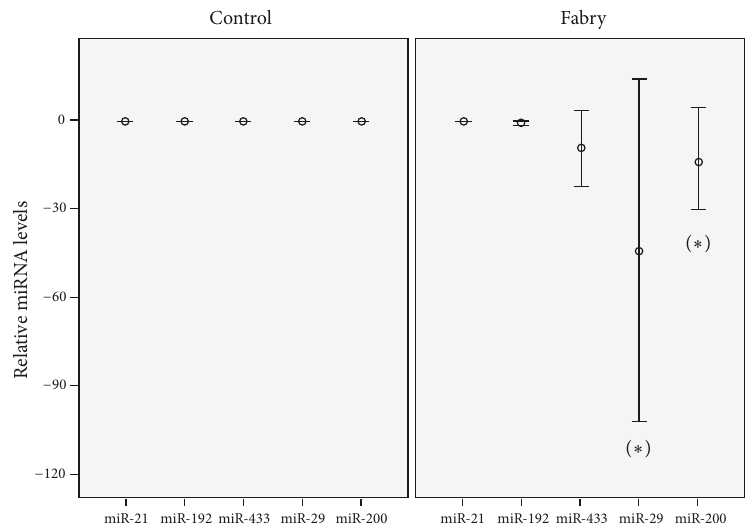
Figure 1: Relative expression levels of miRNAs in urinary sediment of controls and FD patients . Bars represent 2 − (cid:2)(cid:2) Ct values calculatedby Delta- Delta Ct ( (cid:2)(cid:2) Ct) method (Confidence interval: 95%). Expression was normalized to U6, and data are represented as means ± SEM. ( ∗ ) p = < 0.005.